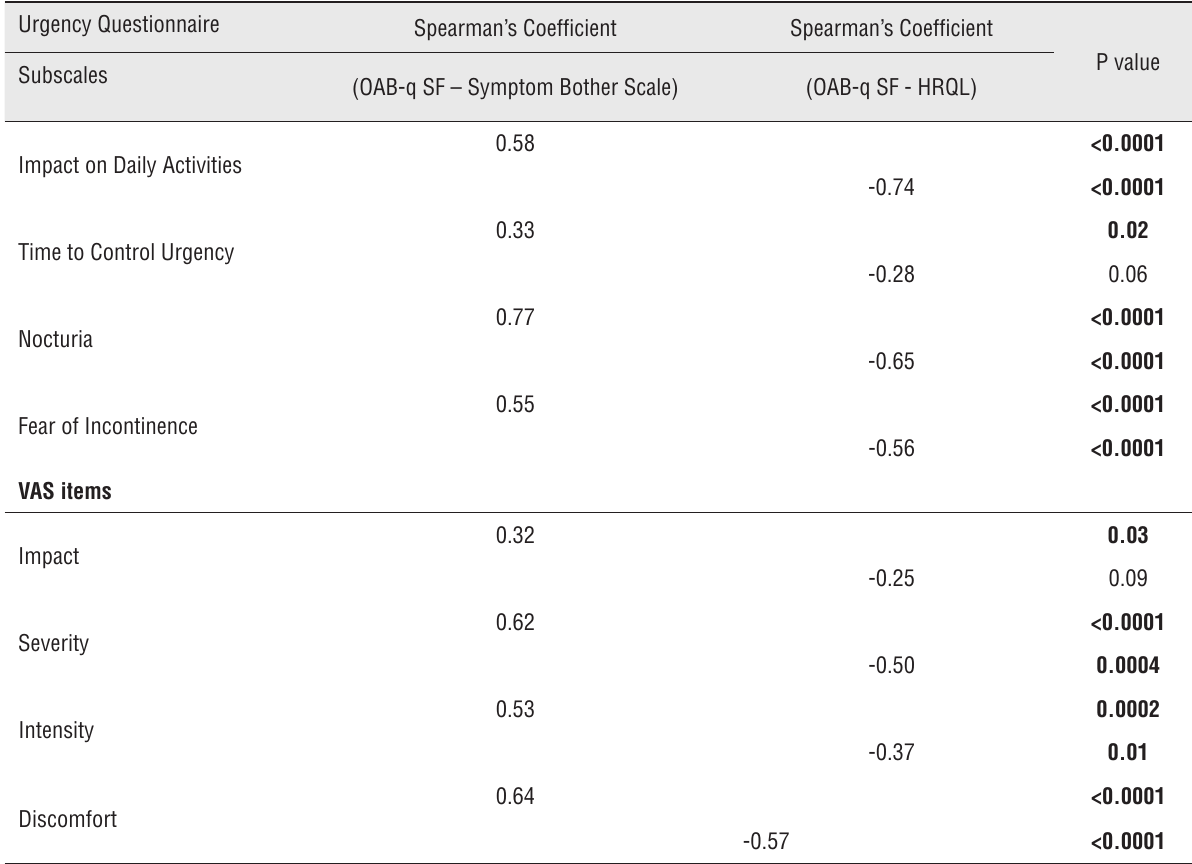
Table 3 - Correlation between the scores of the UQ subscales and vAS items and the OABq-SF (criterion validity). Urgency Questionnaire